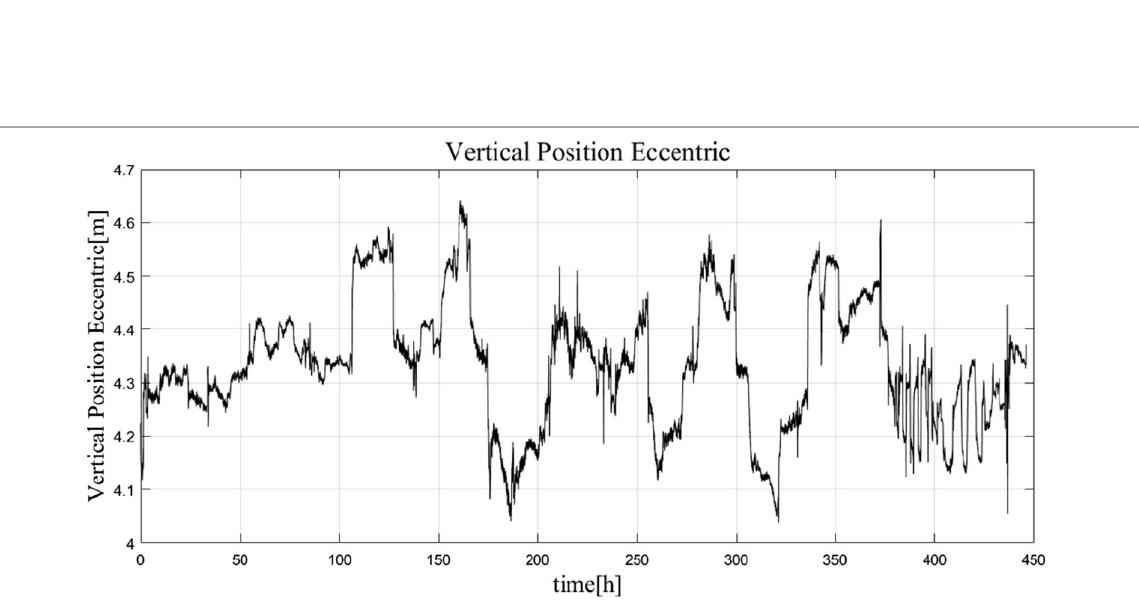
Fig. 16 Elevation eccentricity of the whole